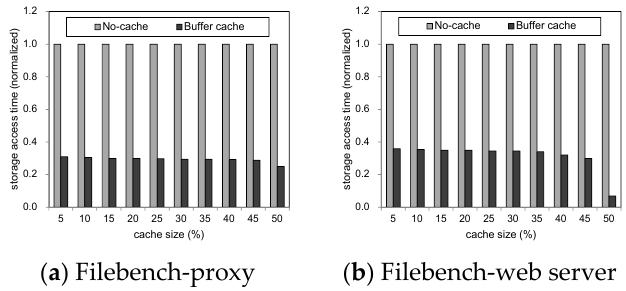
Figure 5. Performance effects of the buffer cache when storage is the HDD.